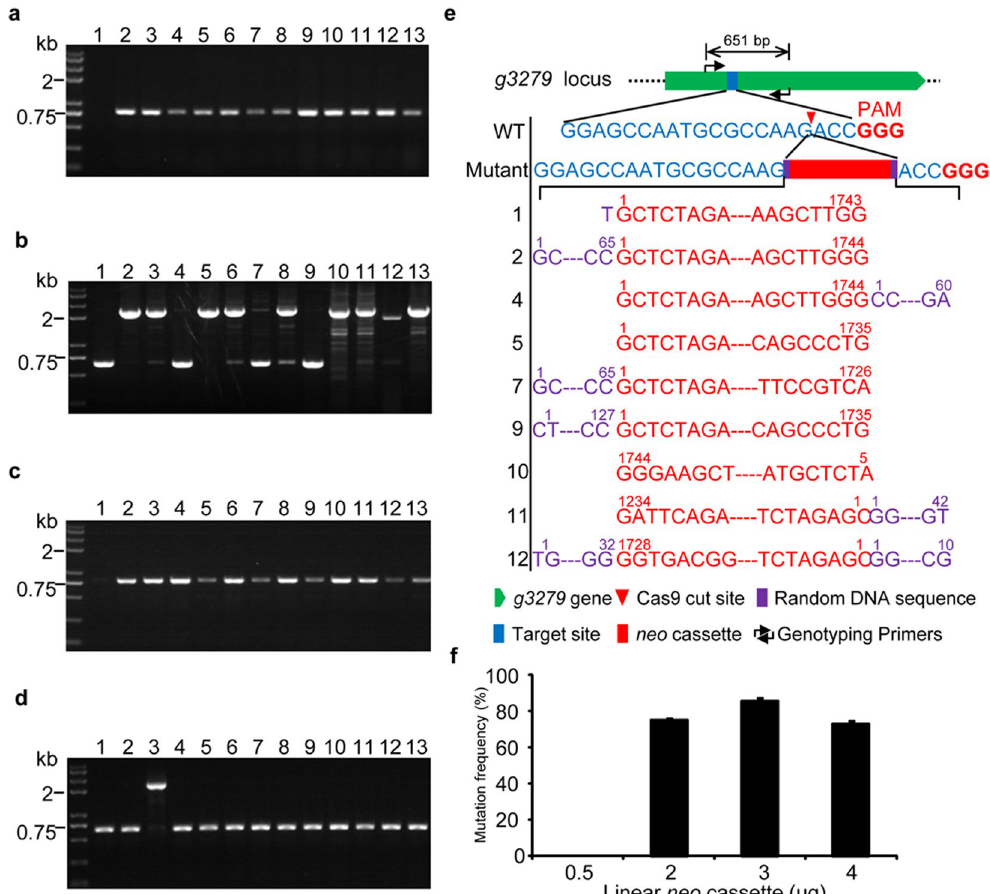
Figure 3. Efficient gene disruption by co-transformation of in vitro transcriptional gRNA and the linear marker gene cassette. ( a ) Analysis of the integration of neo gene into the genome of G418-resistance clones generated by co-transformation of the in vitro transcriptional gRNA and linear neo cassette into the JN1001. ( b ) PCR amplification of the DNA regions surrounding the target site of the clones described in ( a ) using primers flanking the target site. ( c ) Analysis of the integration of neo cassette into the genome of G418-resistance clones generated by co-transformation of the in vitro transcriptional gRNA and circular plasmid pBSKII-PtrPC- neo - TtrPC containing the neo cassette into the JN1001. ( d ) PCR amplification of the DNA regions surrounding the target site of the clones described in ( c ) using primers flanking the target site. ( e ) Sequence analysis of PCR products generated in ( b ). ( f ) Analysis of the effects of usage amount of linear neo cassette on the mutation efficiency. (( a–d ), lane 1: JN1001; lane 2-13: G418-resistance clones (No.